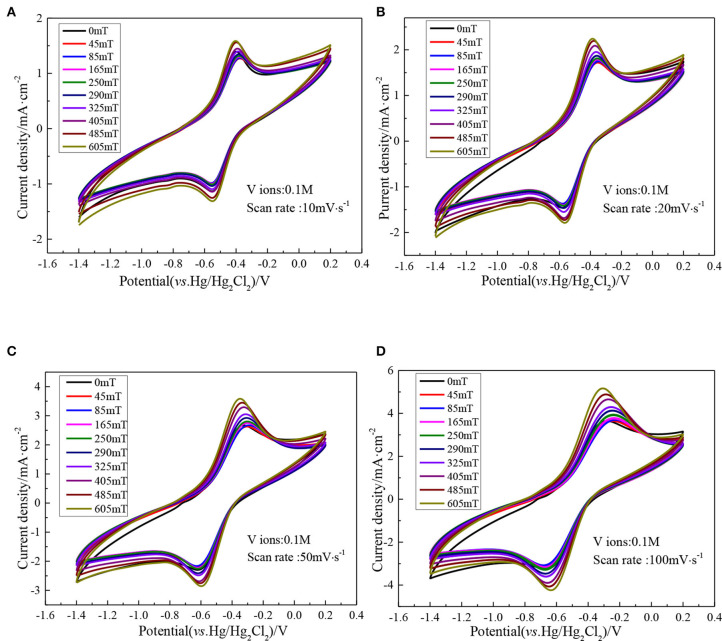
CV curves of 0.1M VCl3 adding different magnetic field intensities at different scan rates, (A) 10 mV·s−1; (B) 20 mV·s−1; (C) 50 mV·s−1; (D) 100 mV·s−1.